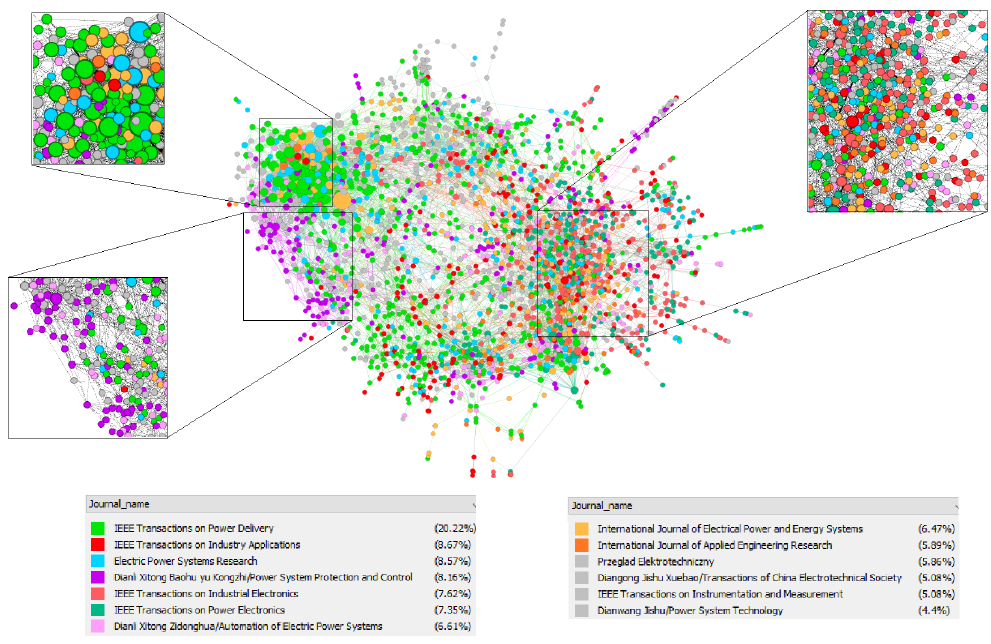
Figure 3. Citations among